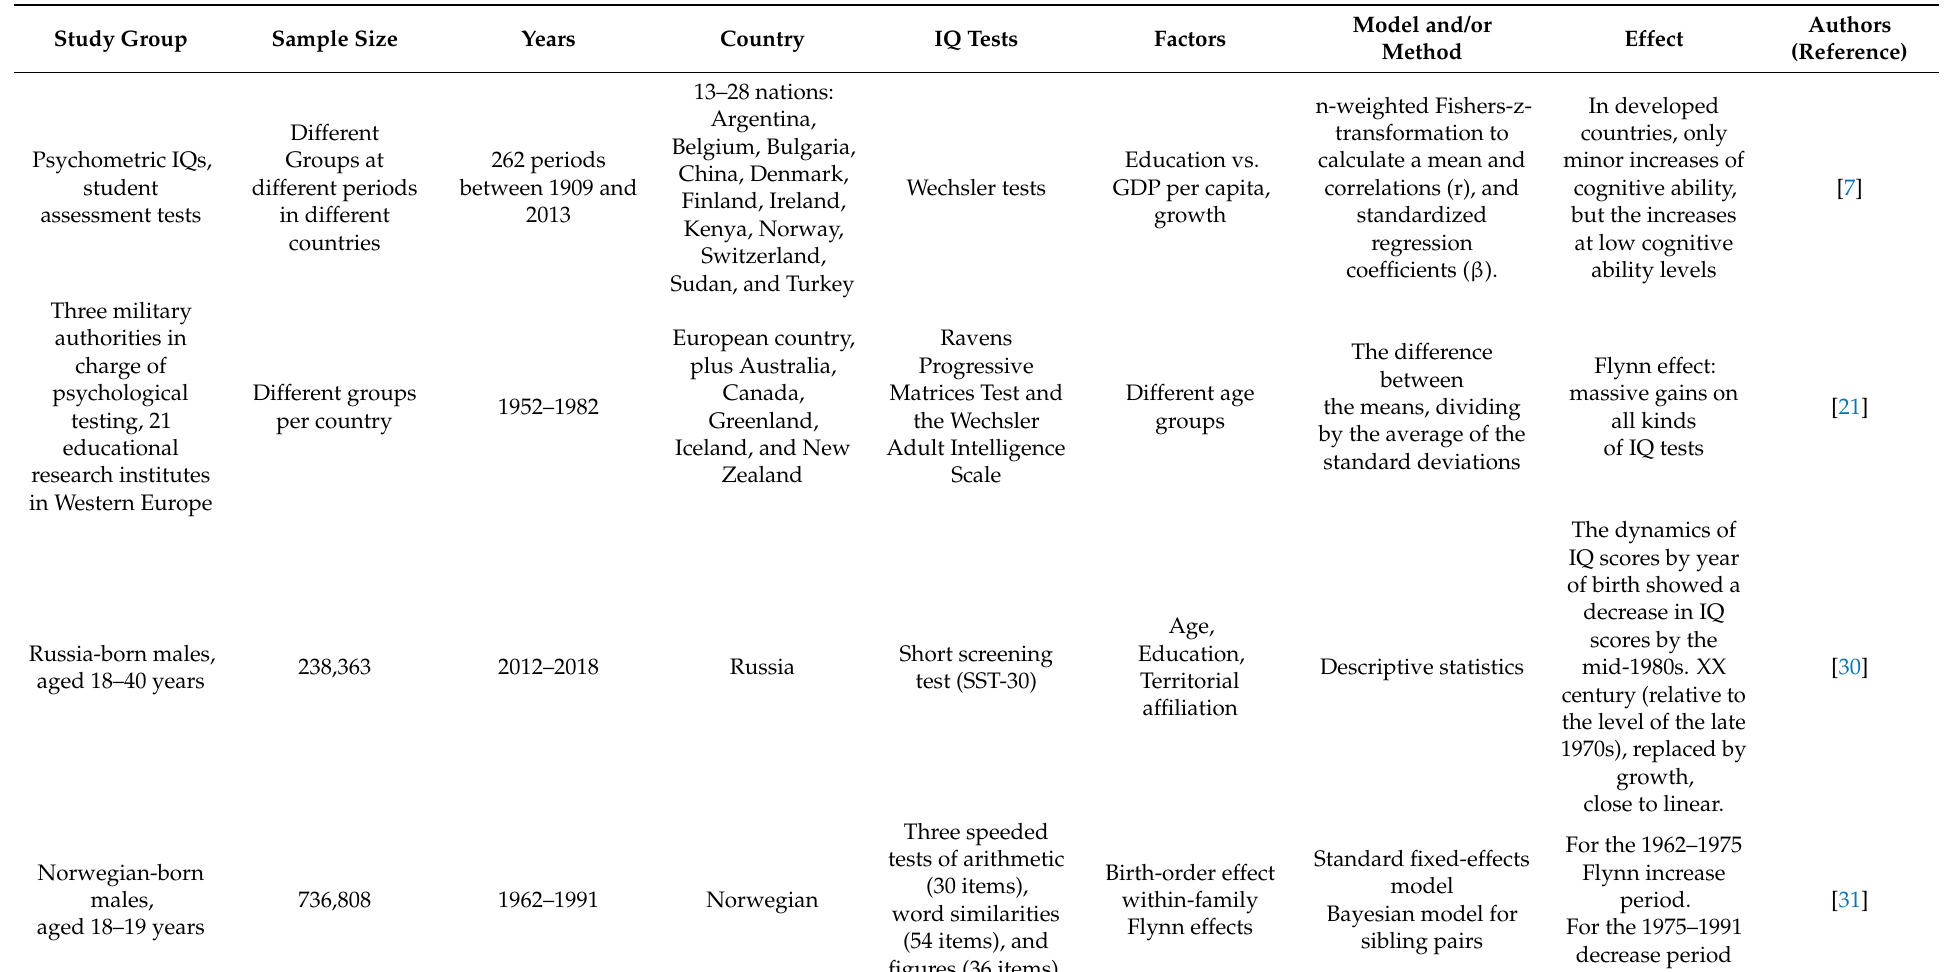
Table A1. Current study of the Flynn